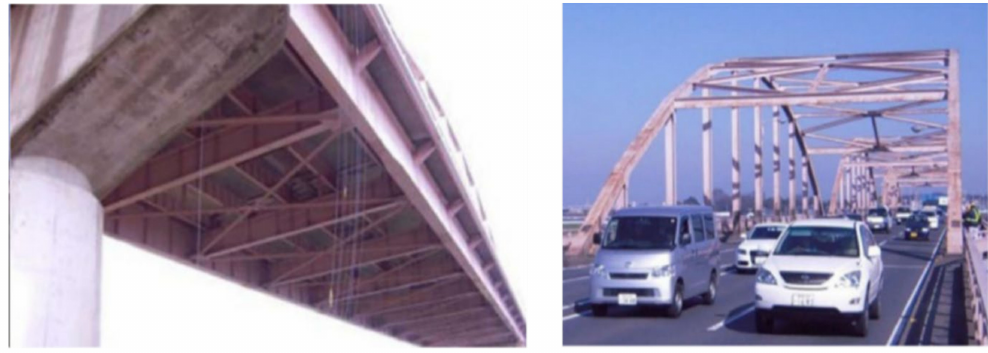
Figure 18. Two views of a steel arch bridge